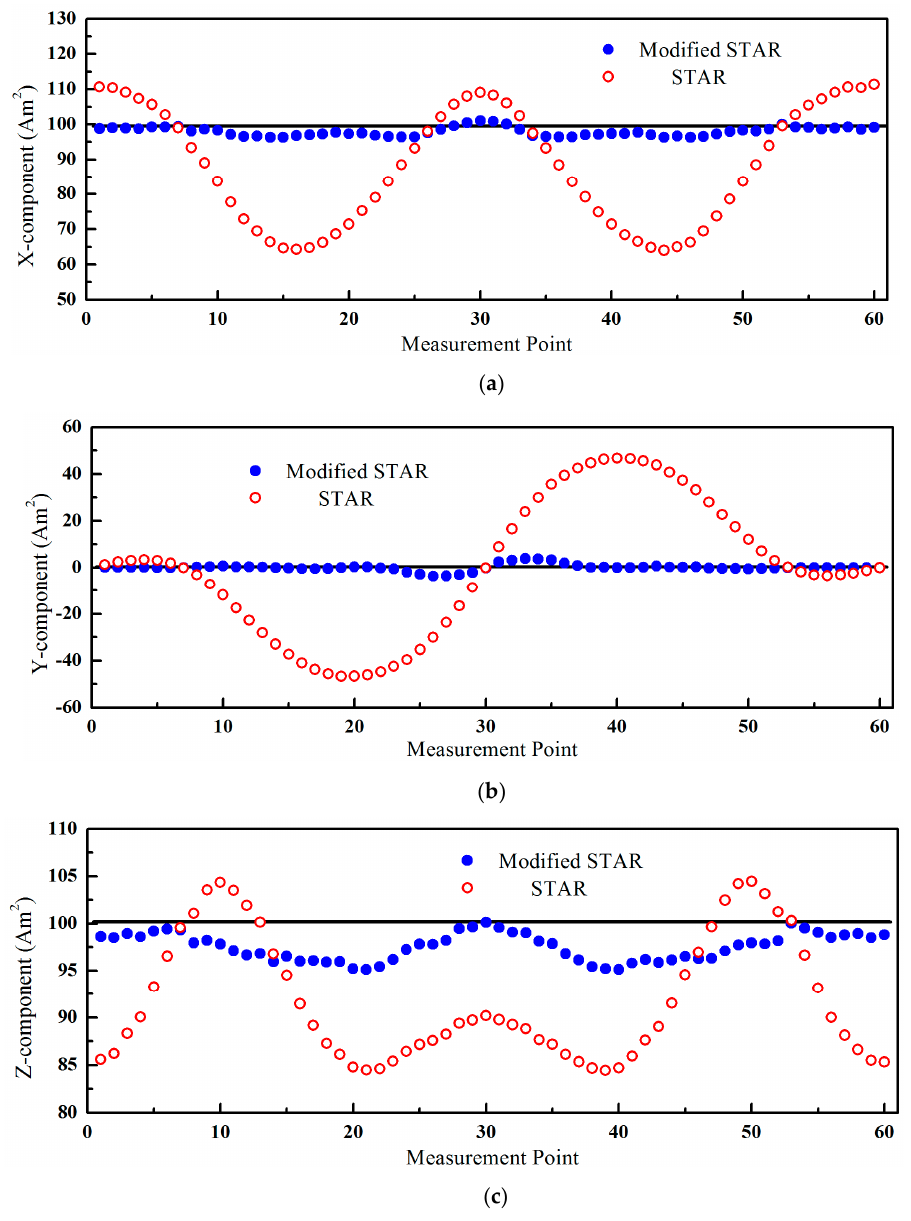
Figure 3. The estimated magnetic moment of the two methods. ( a ) X-component; ( b ) Y-component; ( c ) Z-component.